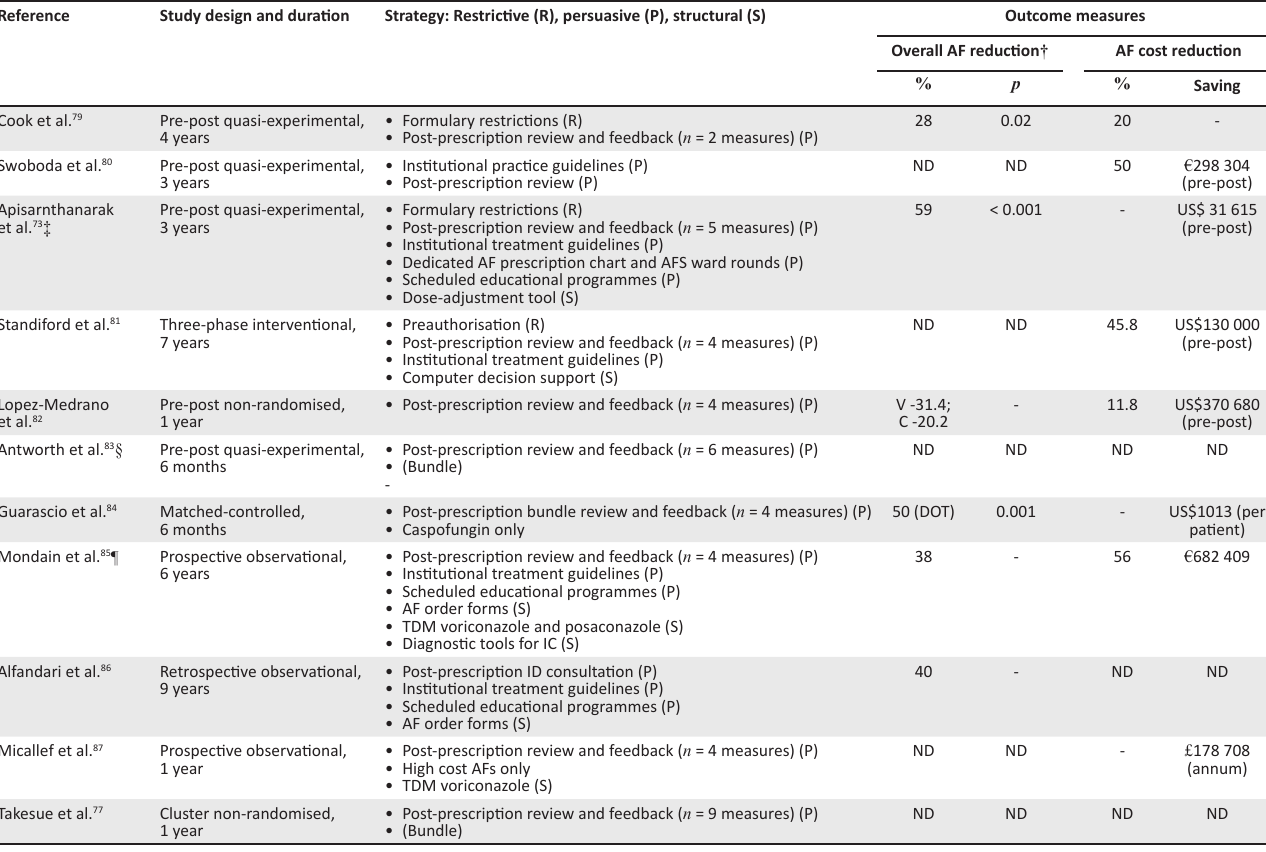
TABLE 1-A1: Impact of antifungal stewardship programmes on non-patient–related outcome measures.